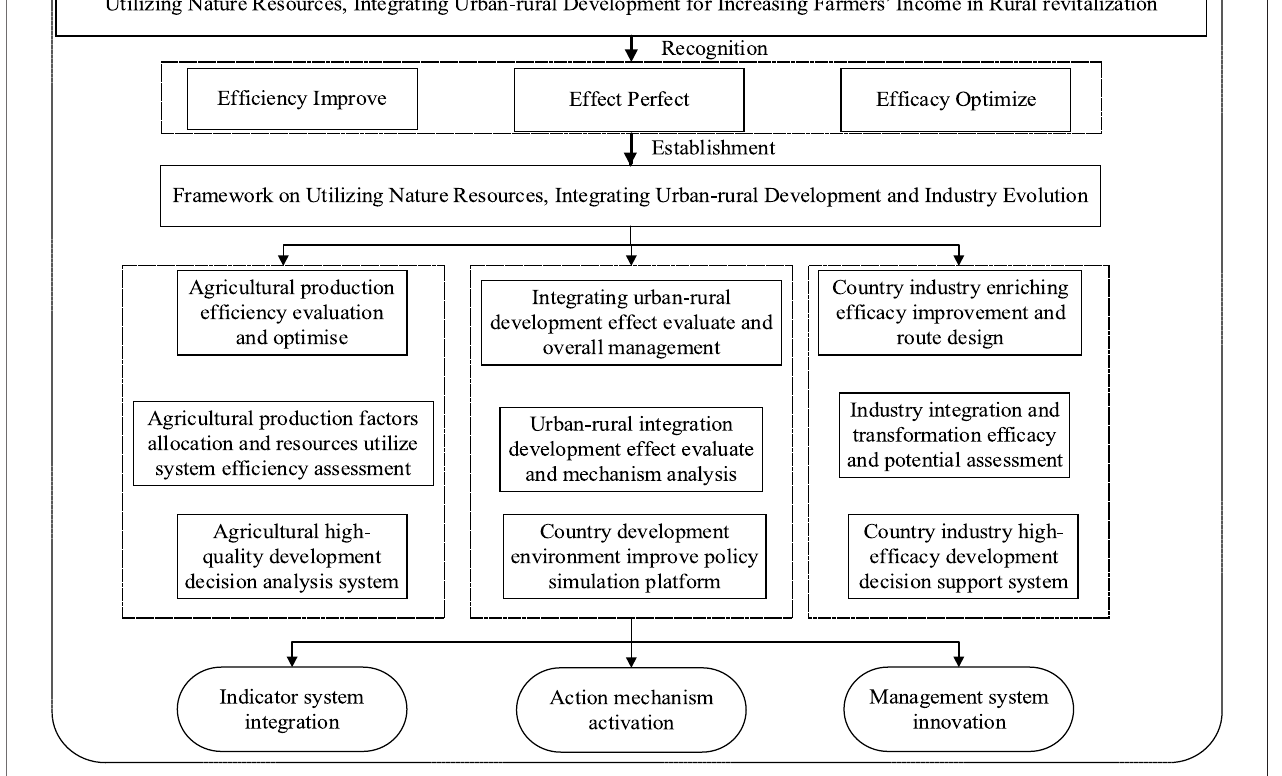
Frontiers in Environmental Science |